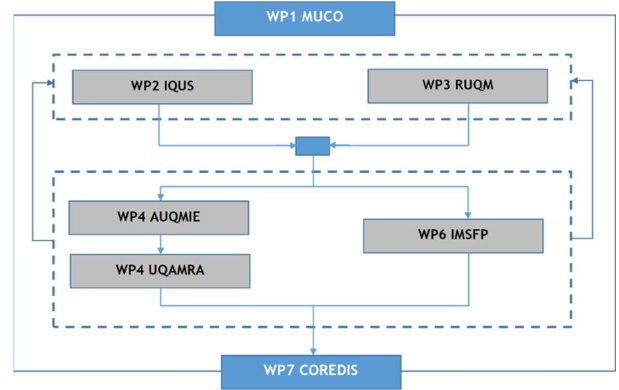
Fig. 6. MUSA Work Package